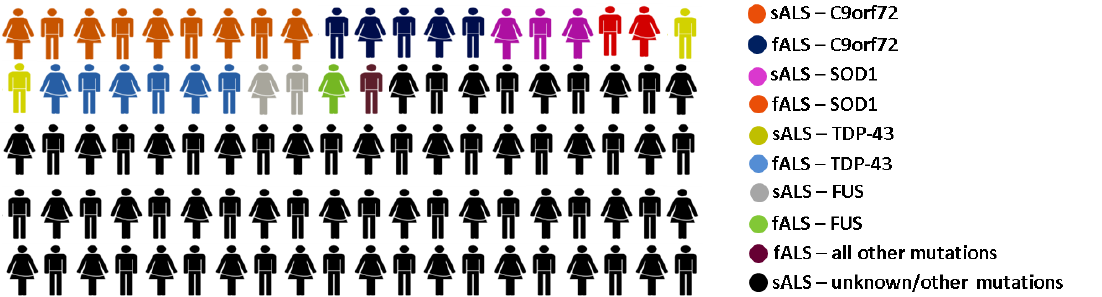
Figure 1. Graphical representation of the approximate frequencies of familial and sporadic ALS cases in the overall affected patient population, rounded to the nearest integer. Frequency of causes are expressed per 100 ALS patients and do not account for sex differences. Infographic generated from the upper frequency limit summarised in